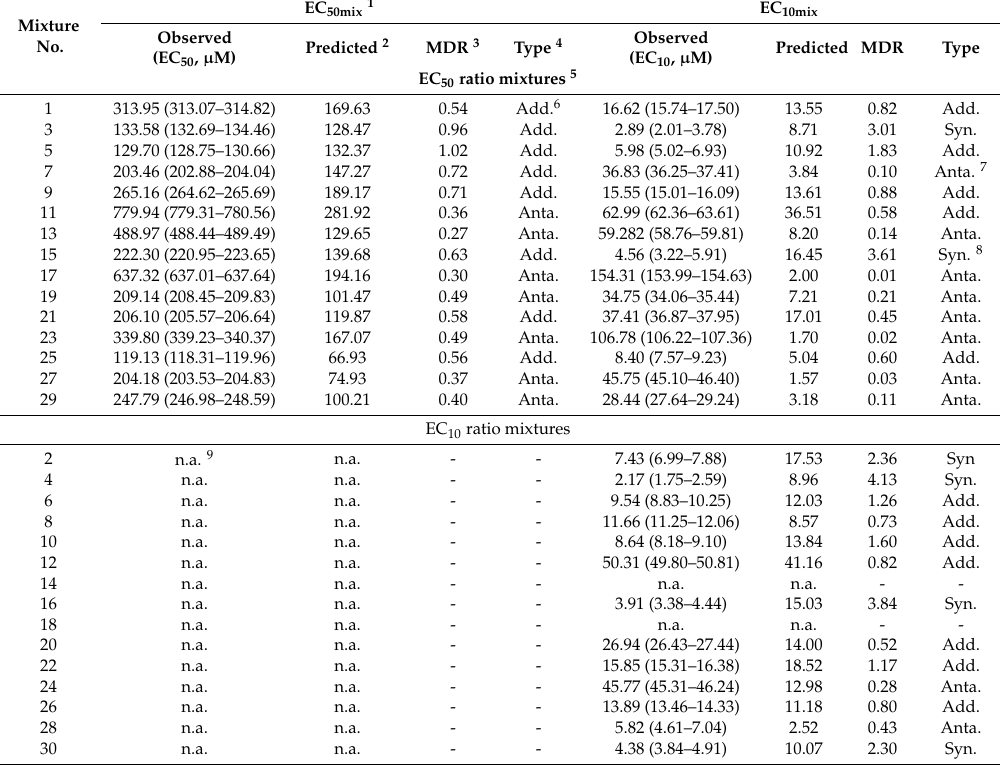
Table 4. Observed and predicted EC x mix values of tested mixtures of pharmaceuticals and pesticides in binary combinations, and MDR values to address the interactions between components (the 95% confidence intervals are provided in the